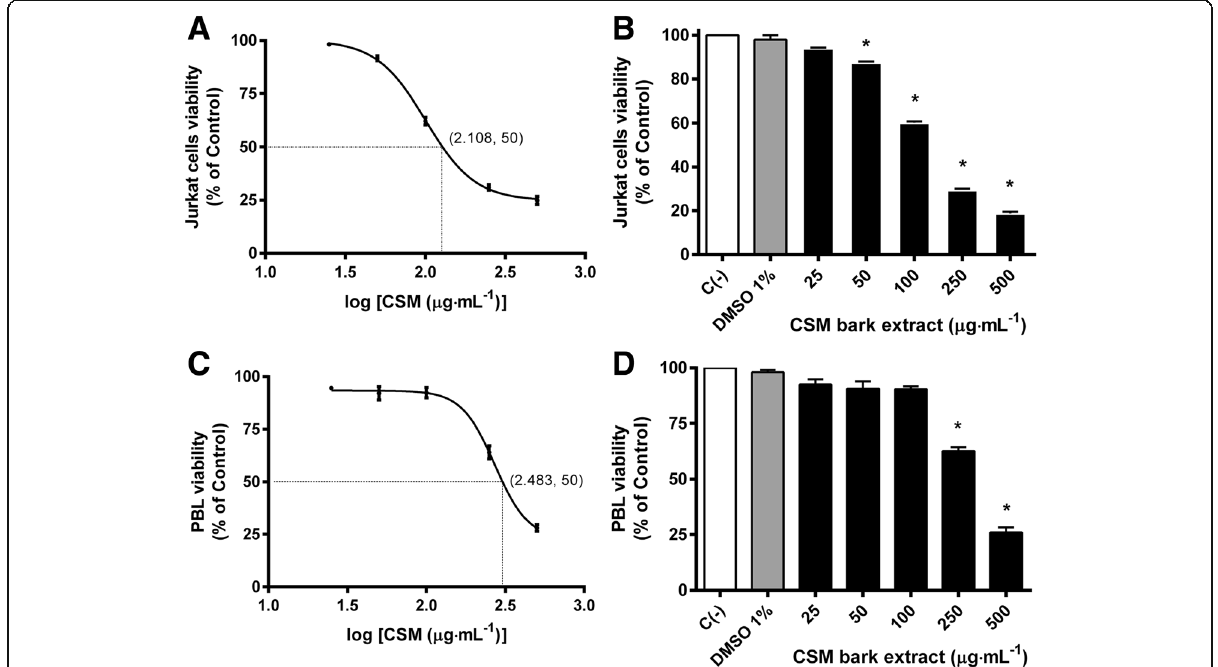
Fig. 1 Jurkat cells and PBL viability after 24 h treatment with CSM bark extractCell viability was evaluated by FCM (panels a and c ) and MTT assay (panels b and d ) as described in Methods. IC 50 was obtained by curve fitting of viability after 24 h treatment with CSM bark extract for Jurkat cells ( a ) and PBL ( c ). Data are presented as mean ± SEM of five independent experiments. Data were analyzed by repeated ANOVA followed by Bonferroni post-test. * p < 0.05 vs